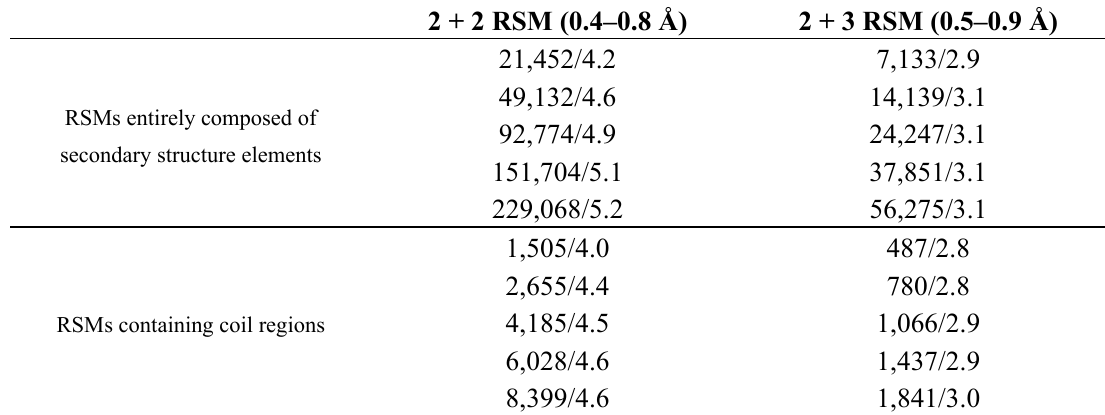
Table 2. Summary of RSMs with similarity requirements for all heavy atoms. Summary of the number of recurrent non-contiguous structural motifs of different types and following slash-symbols: the average degrees of recurrence, for different RMSD cutoff values, for all heavy atoms, in increasing order from top to bottom with a step size between rows of 0.1 Å.